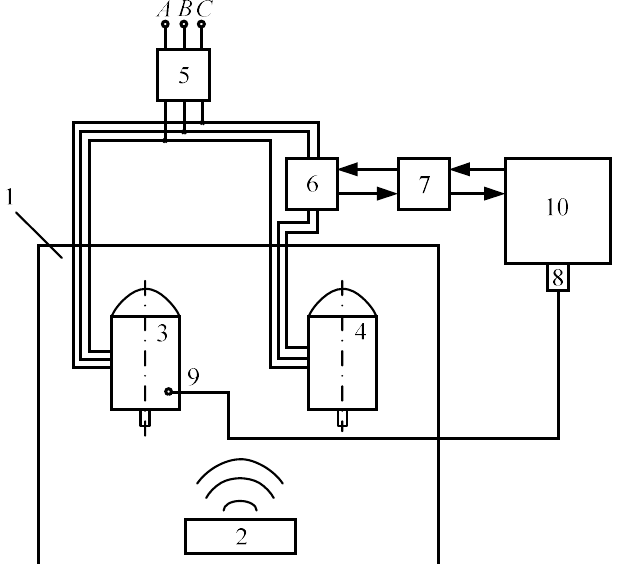
Figure 7. Test bench, a block diagram: 1, test chamber; 2, adjustable air heater; 3, base EM; 4, tested EM; 5, power switch: 6, EM thermal protection device, which implements a new phase control method for EM SW temperature; 7, data collection system E502 manufactured by “LKard” (Moscow, Russian Federation), 8, miniature electronic thermometer (MET) with a remote digital temperature sensor 9; and 10, personal computer (PC).